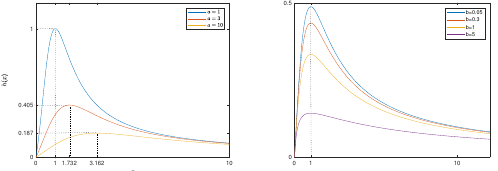
Figure 1. Graph of the generalized Holling type IV functional response H ( x ). i) In the left panel for different values of the parameter a , with q = 1, and b = 1 fixed. The values are: a = 1 (blue), a = 3 (red), a = 10 (sienna). ii) In the right panel, different values of the parameter b , are considered for q = 1, and a = 1 fixed. The values are: b = 0 . 05 (blue), b = 0 . 3 (red), b = 1 (orange), b = 5